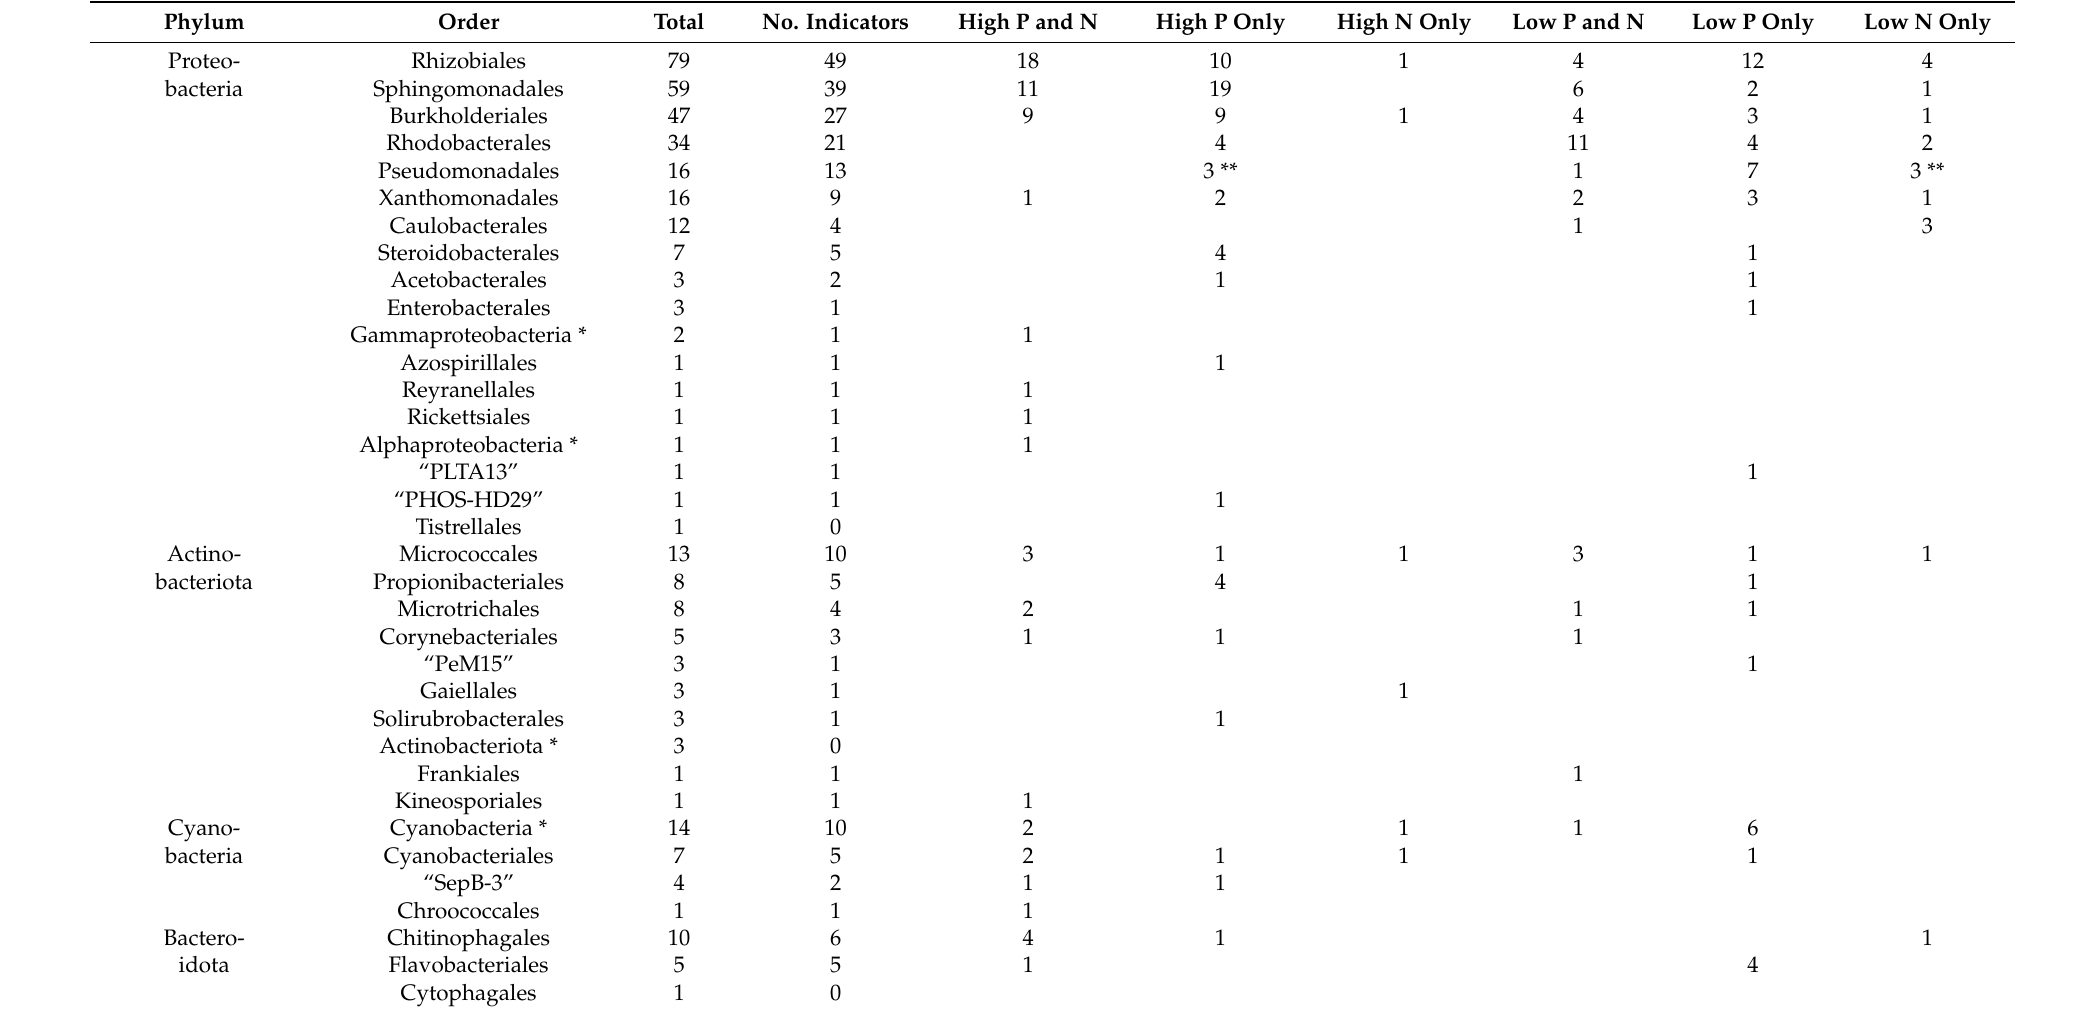
Table 5. Nutrient indicator ASVs by bacterial